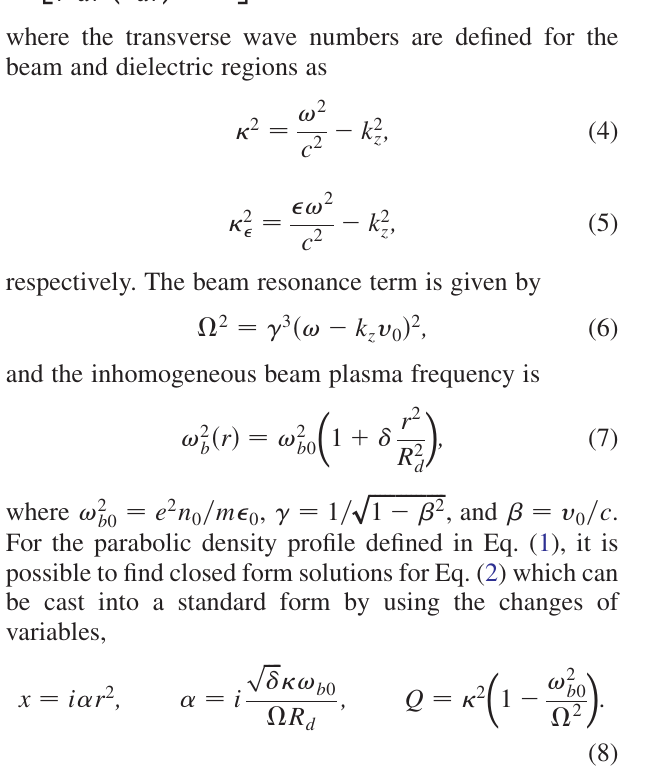
The dispersion relation is obtained by applying boundary conditions to the system, which allows the three undeter- mined constants E 1 , E 2 , and E 3 to be related. The boundary conditions for the tangential electric fields are E ð R Þ ¼ E ð R Þ . In addition, the boundary condition and E z d z(cid:3) d